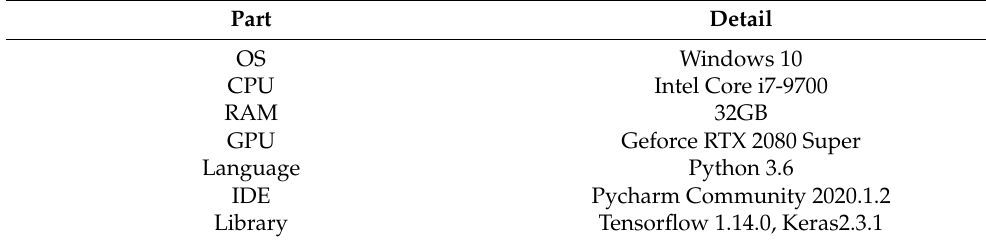
Table 2. Development